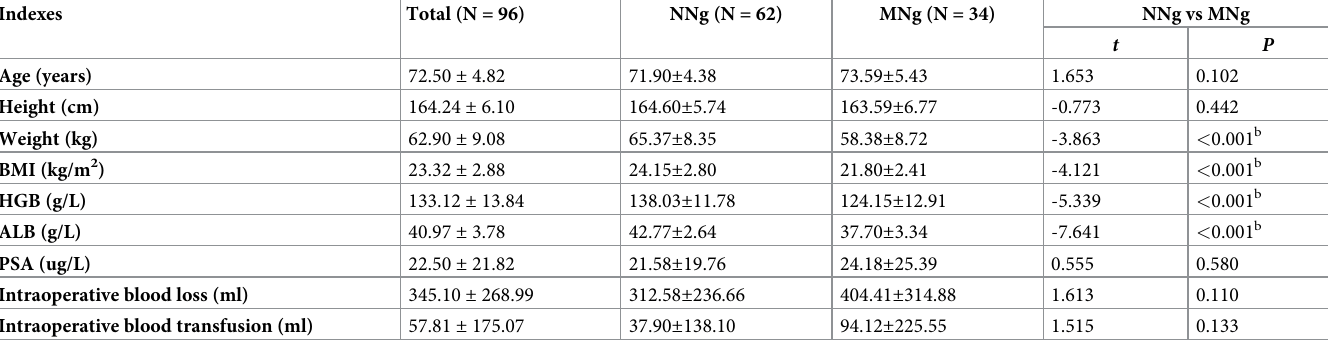
Table 1. General characteristics, preoperative laboratory indexes and intraoperative conditions of patients.